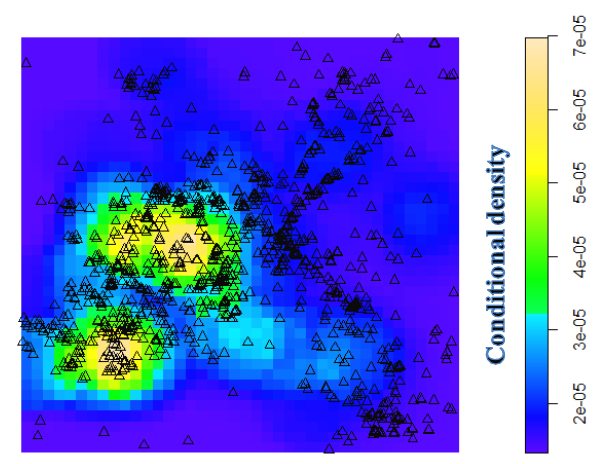
Figure 6. Fitted marked Gibbs point process. The triangles correspond to the locations of SMS 7